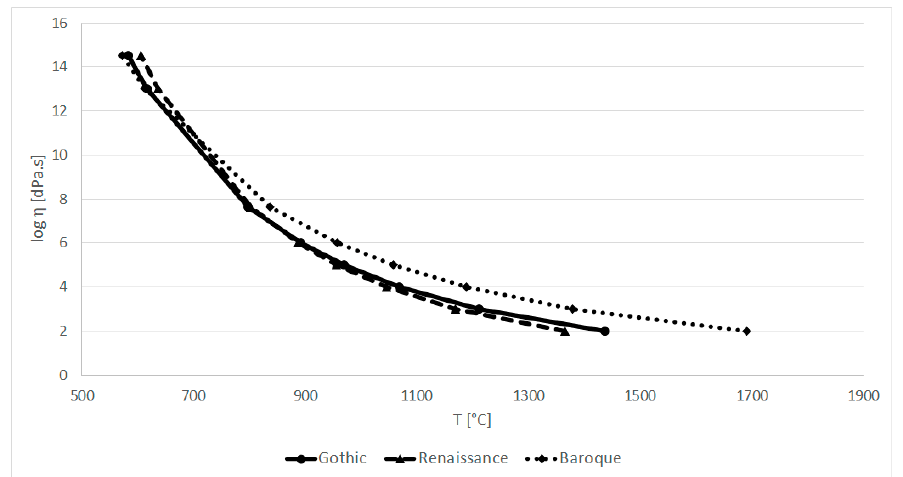
Figure 8. Dependence of viscosity on temperature for model glasses.